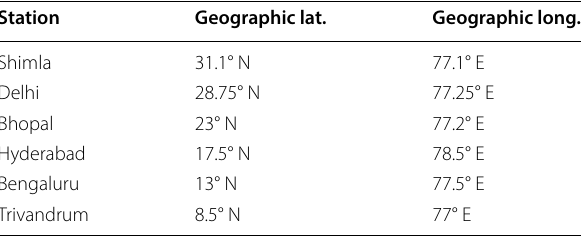
of the GPS receiver stations used along with their geographic co-ordinates Station Geographic lat. Geographic long.